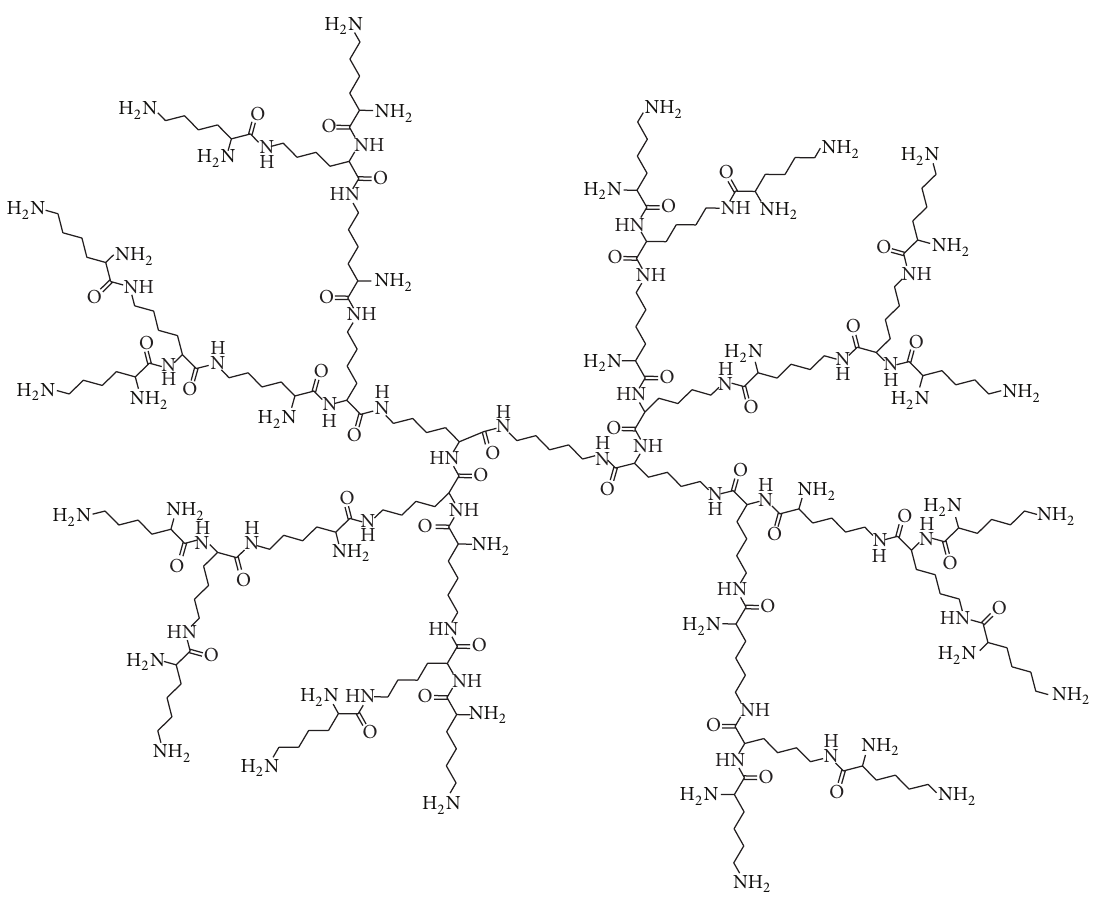
Figure 6: Poly(L-lysine) (PLL) G3